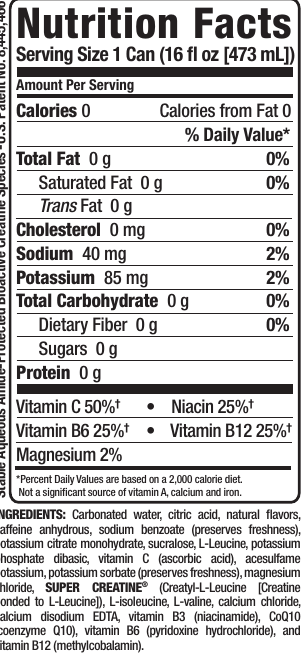
Figure 1. Nutrition Facts panel of BANG energy